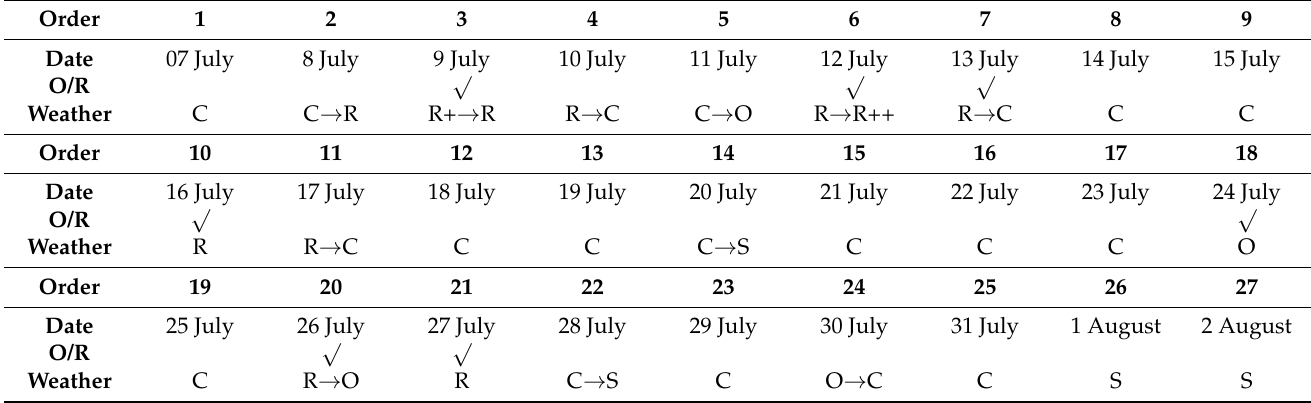
Table 2. Daily weather records from 7 July 2019 to 2 August